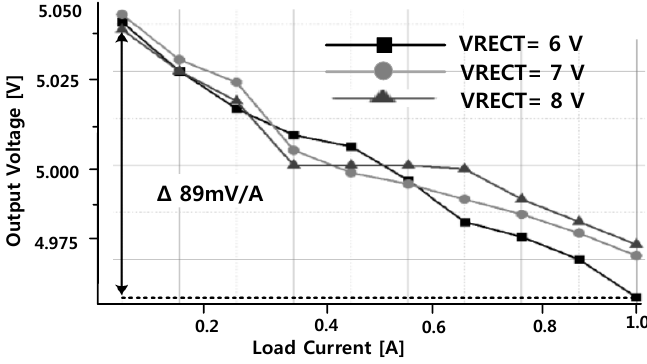
Figure 13. Measured output voltage of multi-feedback LDO (MF-LDO).